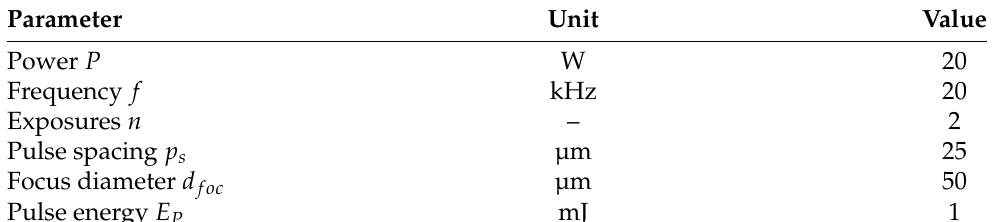
Table 2. Laser structuring parameters for the generation of a quasi-chaotic nanostructure. Parameter